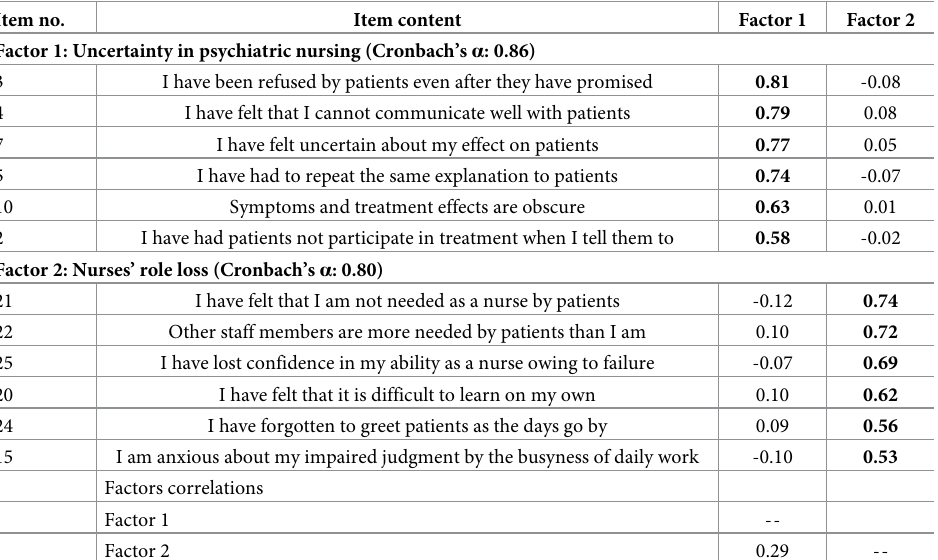
Table 3. Factors related to decreased self-efficacy among psychiatric nurses (n = 132). Item